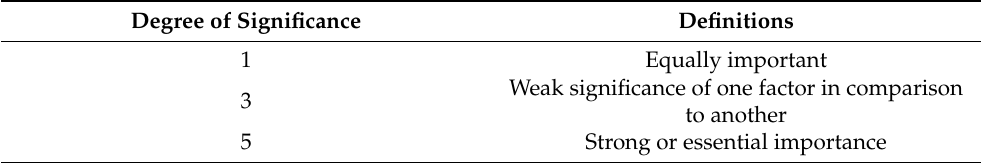
Table 4. Measures of